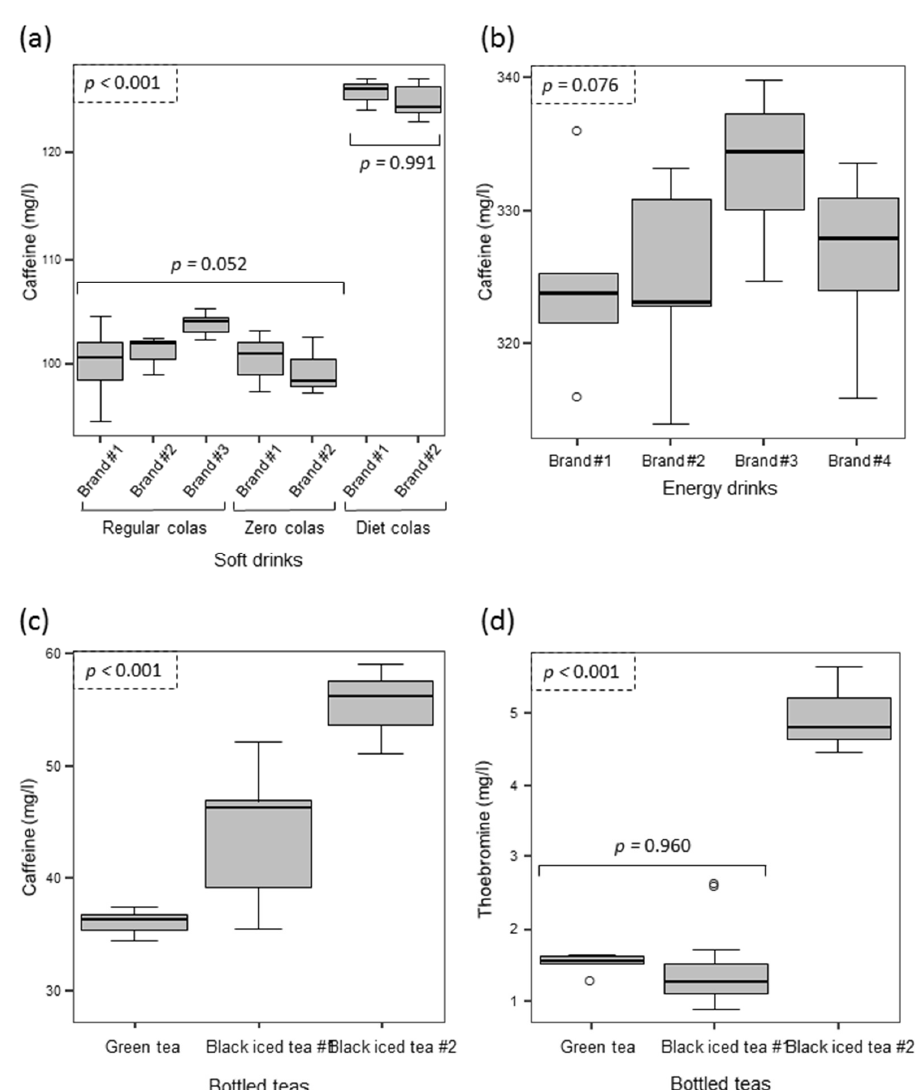
Figure 1. Box ‐ plot displaying the distribution of the concentrations (in mg/L) detected in the